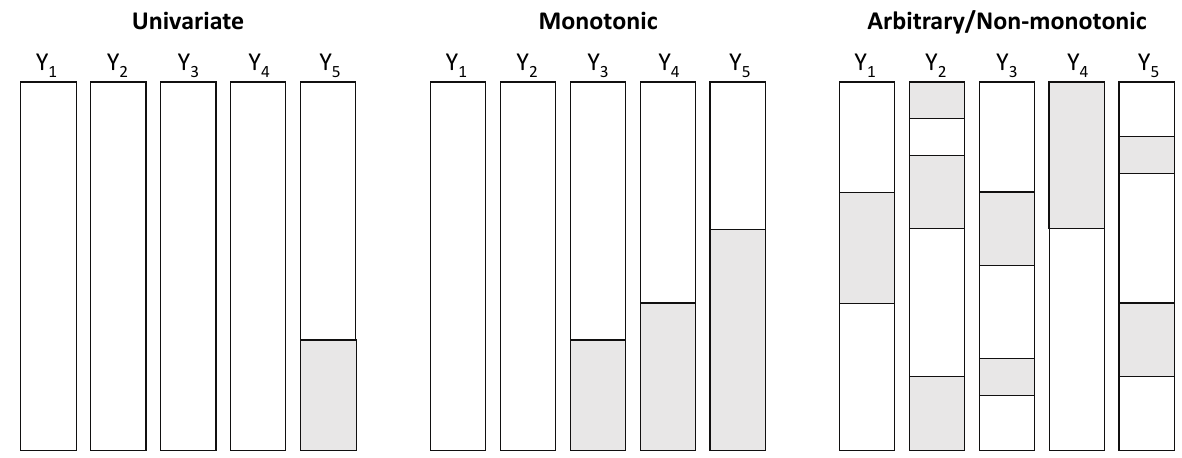
Figure 3. Missing data structures. White sections indicate the presence of data, shaded sections their absence.